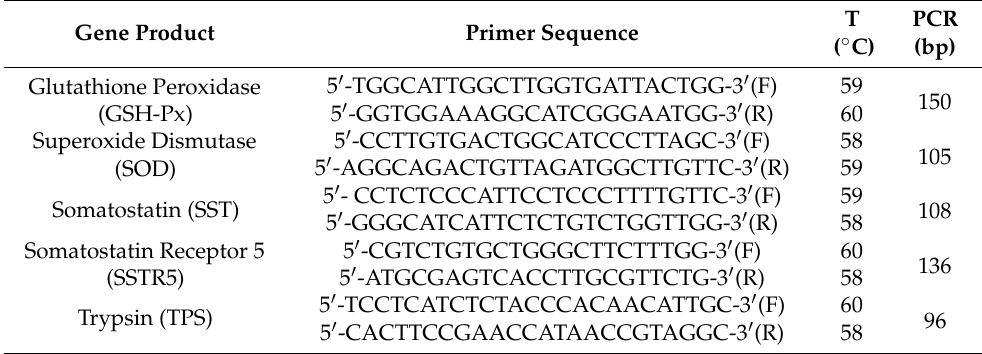
Table 2. The sequence of primers designed for the RT-PCR studies. Gene Product Primer Sequence Glutathione Peroxidase